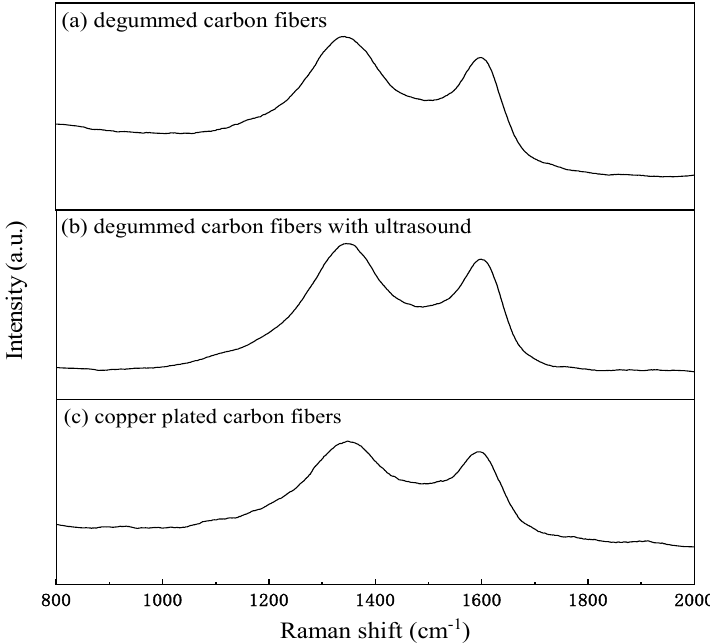
Figure 7. Raman spectroscopy of carbon fibers: ( a ) degummed carbon fibers; ( b ) degummed carbon fibers with ultrasound; ( c ) copper plated carbon fibers.